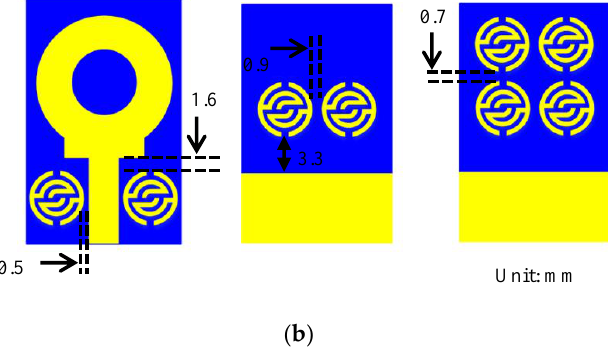
Figure 12. Simulated reflection coefficient with and without MTM. ( a ) the reflection coefficient of the proposed antenna without and with MTM; ( b ) the investigation of efficient positions of proposed MTM with the antenna.